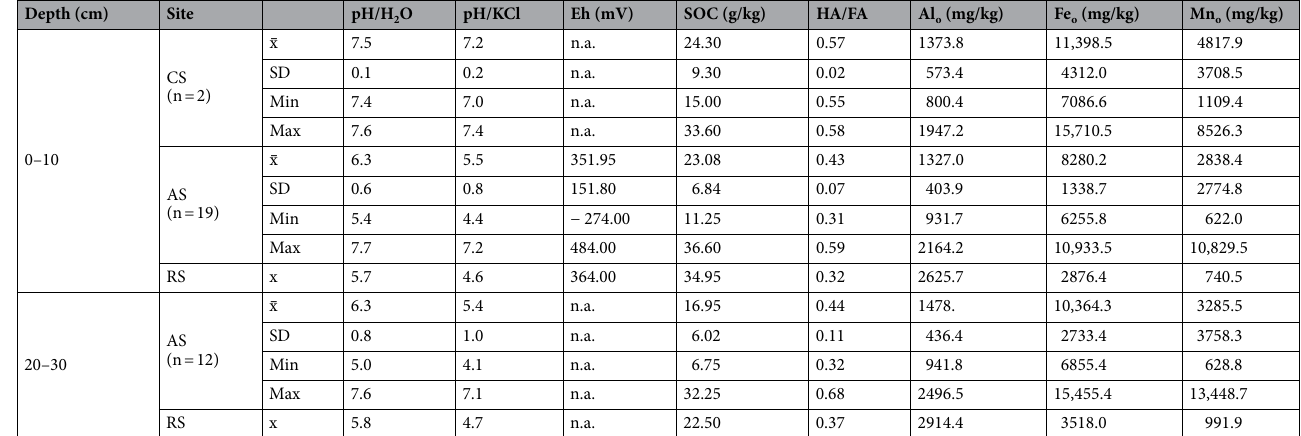
Table 1. Soil chemical properties in the soil depth of 0–10 and 20–30 cm in contaminated, alluvial and reference sites with basic statistical characteristics. AS alluvial site, CS contaminated site, RS reference site, o extracted by oxalate.